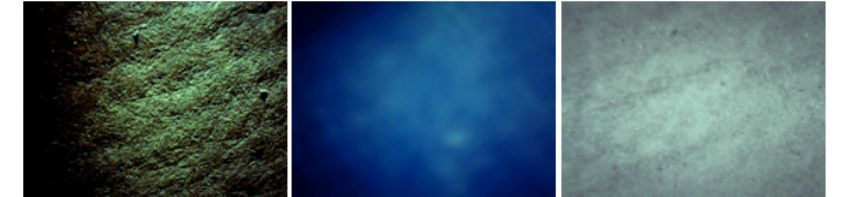
Figure 9. Analysis of Amelia Pavel’s writing in the three reflected lights: white-green (550 nm), UV (365 nm), and IR (850 nm).